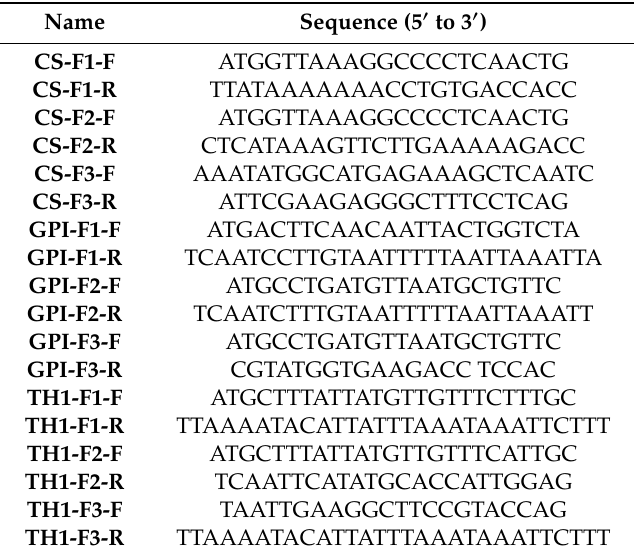
Table 1. List of primers used for cDNA